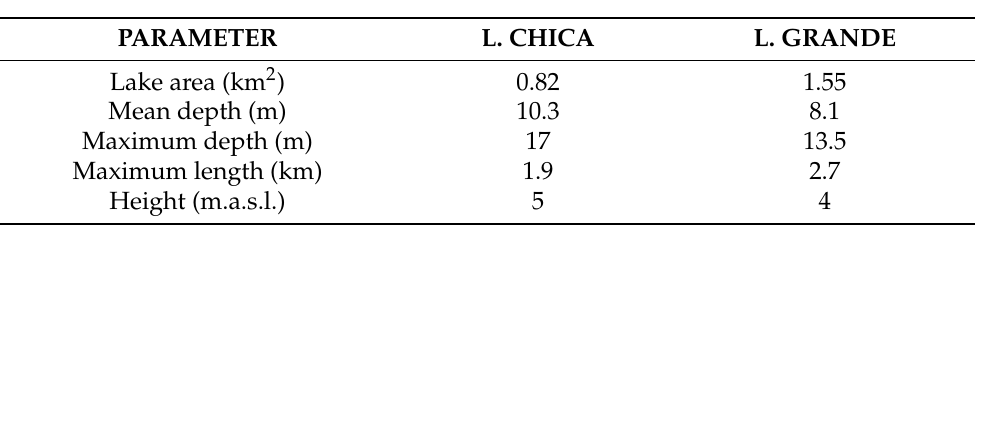
Table 1. Dimensions of the studied lakes